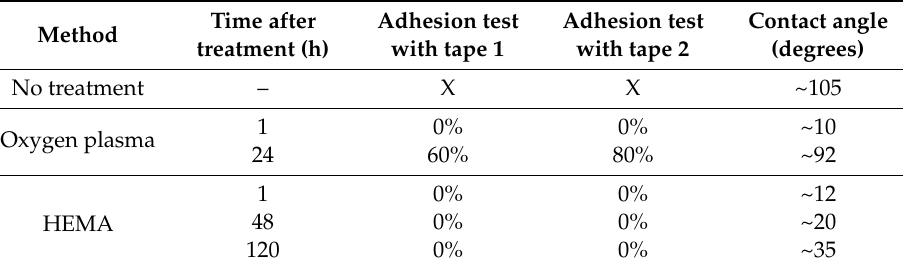
Table 2. Results of adhesion test with tapes 1 and